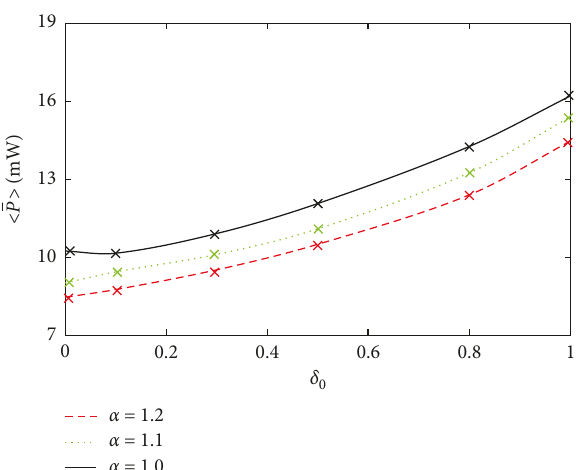
Figure 5: The device’s effective output power as a function of the parameter δ ( Δ �